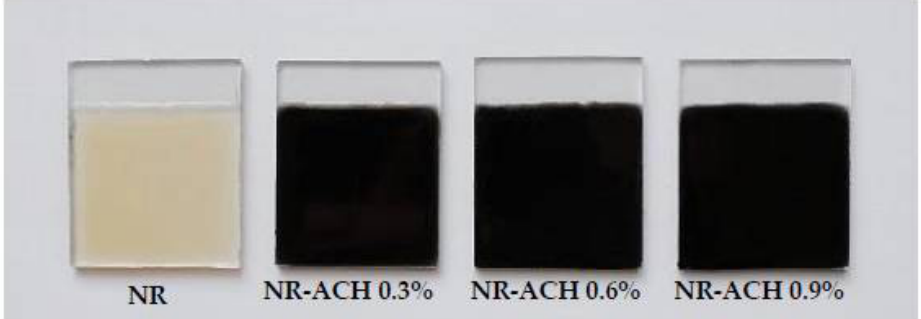
Figure 1. Digital image of the fabricated triboelectric electrodes, including NR and NR-ACH 0.3, 0.6, and 0.9% composites coated on ITO substrates.